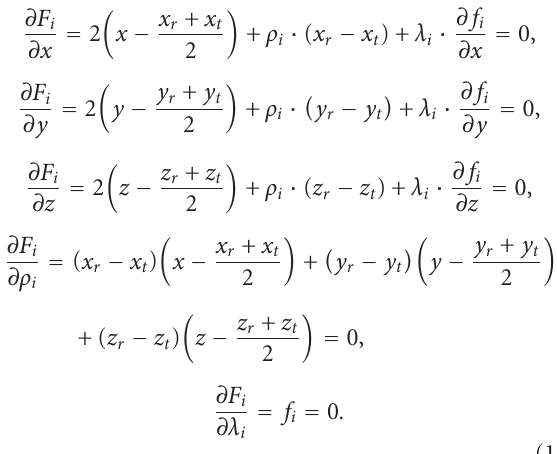
Thus, the intersection between the maximum Fresnel